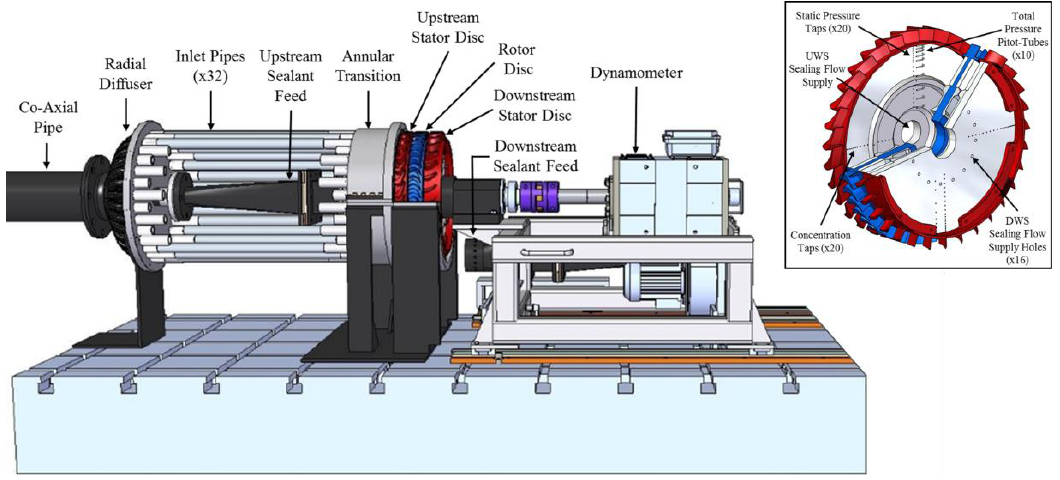
Figure 3. Component view of the experimental facility (some of the inlet pipes and the annulus casing are removed for the purpose of clarity); details of the stage and salient instrumentation are shown inset.